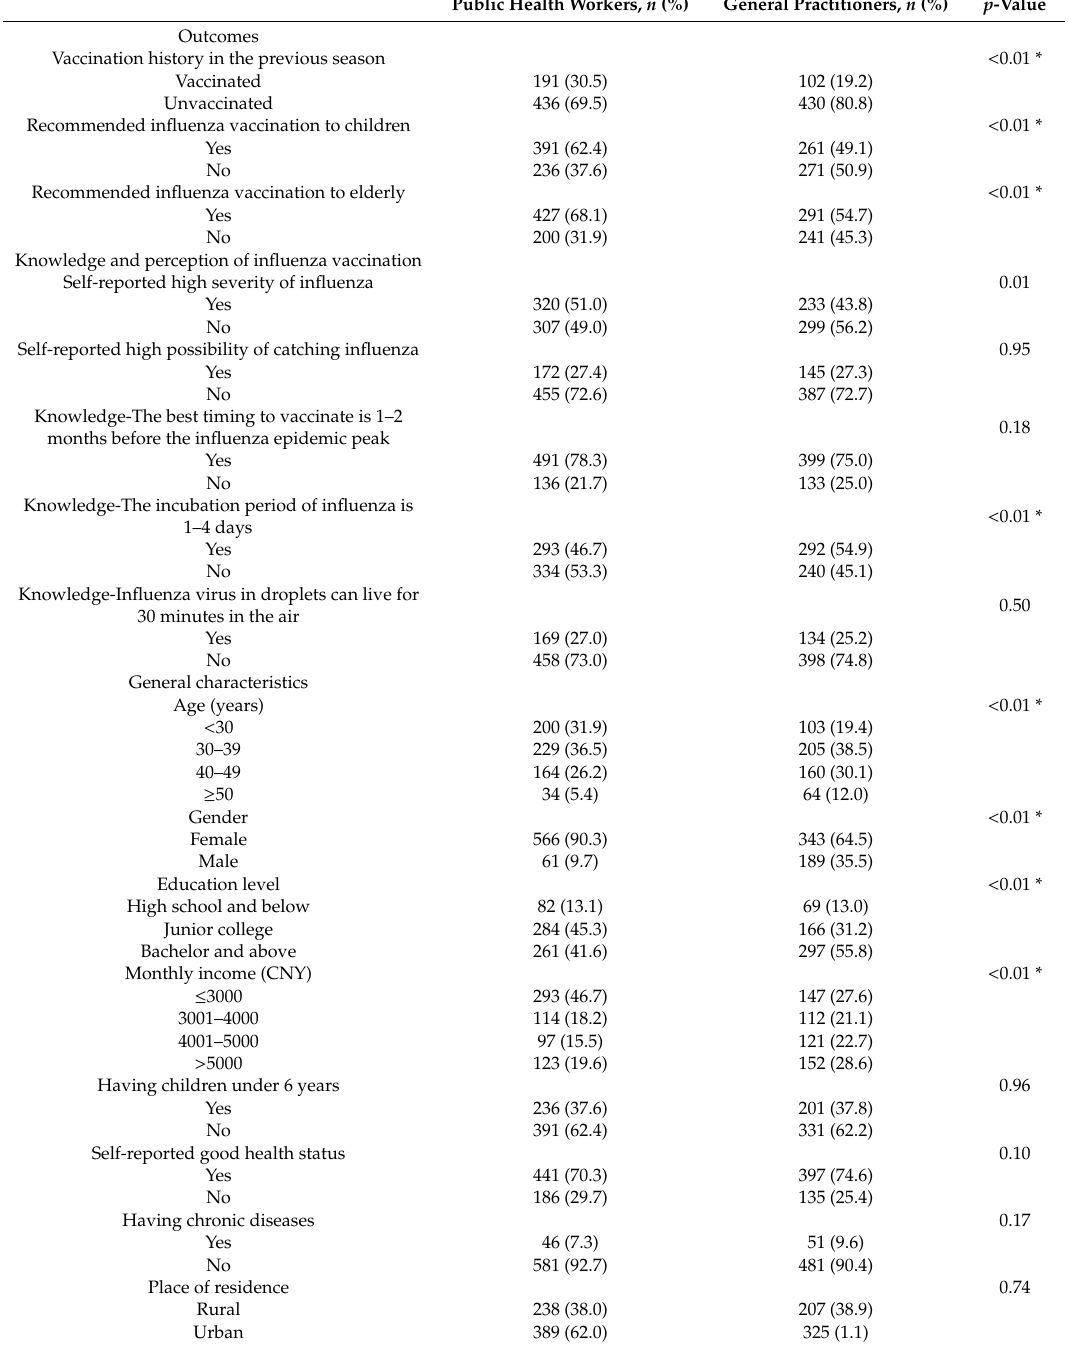
Table 1. Characteristics of surveyed healthcare workers in immunization